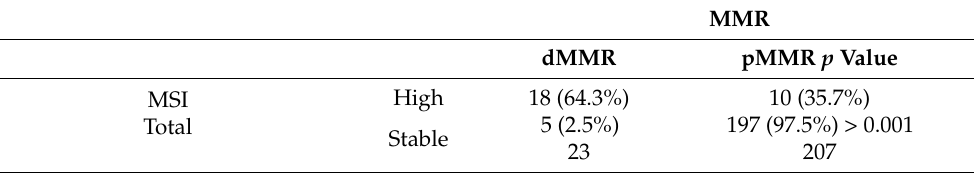
Table 2. MSI by PCR_Fragment Analysis vs. MSI by immunohistochemistry